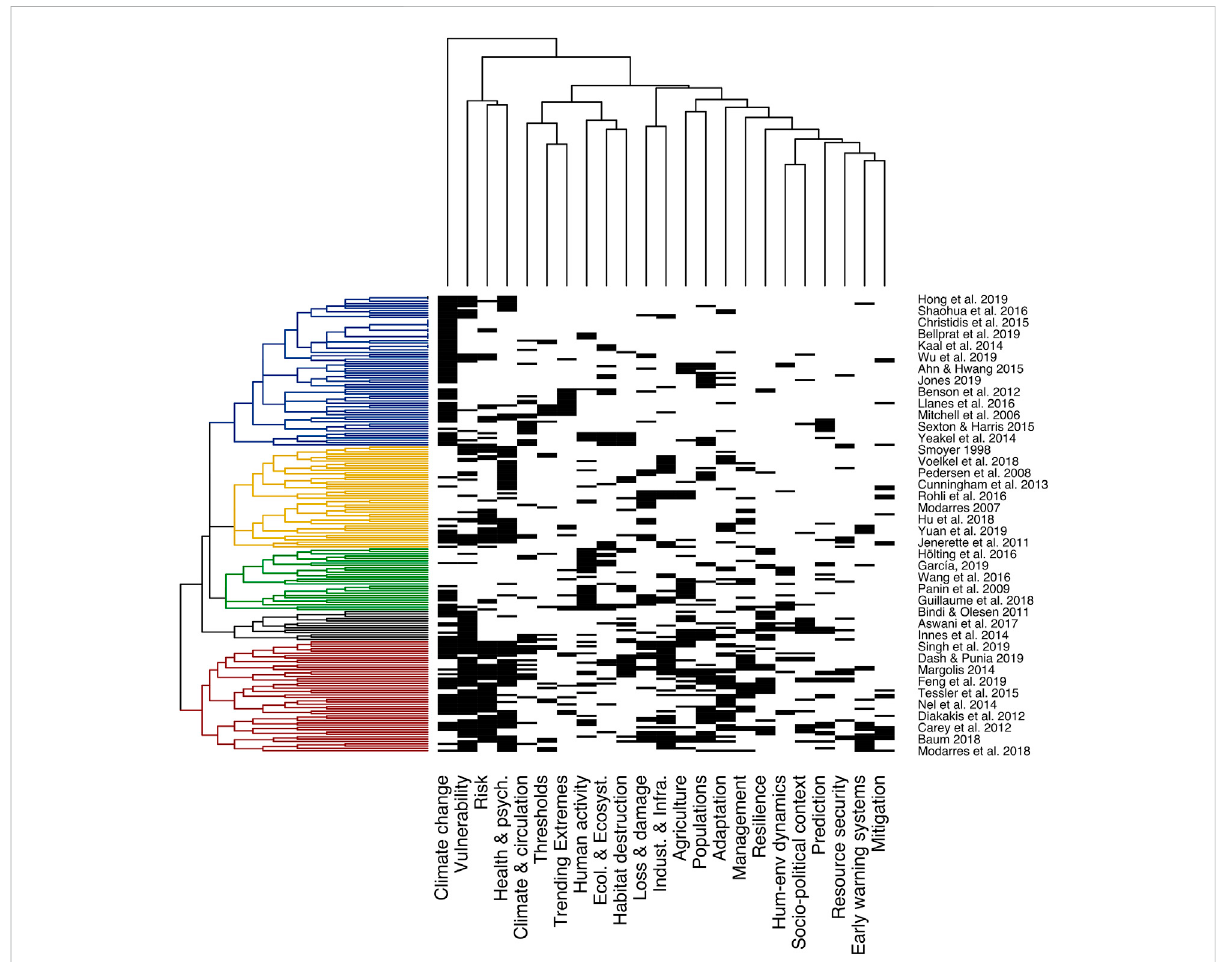
FIGURE 4 Heatmapshowingpaperlikenessandthemeclustering.Papersonthe x -axisandthemesonthe y -axis.Onlythetop20themeswereusedinthis clustering analysis. The clusters are color-coded as follows: health, vulnerability, and risk in red; human-environment interactions in green; human health and well-being in yellow; and climate change dynamics in blue. The full fi gure, with all 200 papers displayed, is presented in the SupplementaryMaterial(SupplementaryFigureS3).Pleasenotethatthis fi gurewasgeneratedpriortosomemergingofthemesandthisdataset is provided as Appendix